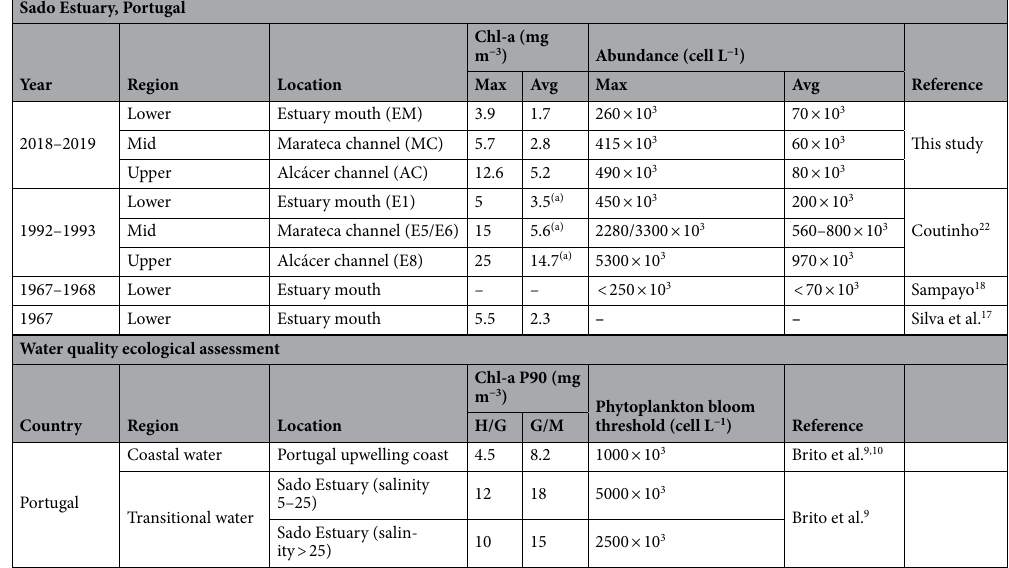
Table 1. Comparison of maximum (Max) and average (Avg) of Chl- a concentrations (mg m −3 ) and phytoplankton abundances (cell L −1 ) obtained during different periods in the Sado Estuary, in the three regions here studied. In the lower section are shown indicative values for water quality ecological assessment. The Chl- a 90th percentiles (P90) (mg m −3 ) are shown for High/Good (H/G) and Good/Moderate (G/M) boundaries. The thresholds for the determination of the occurrence of a phytoplankton bloom (cell L −1 ) are also shown. (a) This value indicates the Chl- a average for the entire referred region, not only for the indicated station.